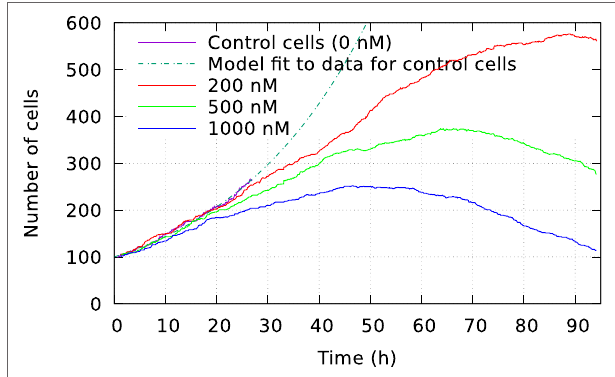
FigUre 2 | Development of cell size population initially consisting of 100 individuals. The cells were exposed to three different YTX concentrations 200, 500, and 1,000 nM. These data result from tracking the cells which may divide or die. A short recording of control cells indicate initial exponential growth with a doubling time 19 h. Note that the development of population size strongly depends on concentration of the toxin which starts to take effect short after exposure. Subsequent results below show large variations in the development for subsets of these three